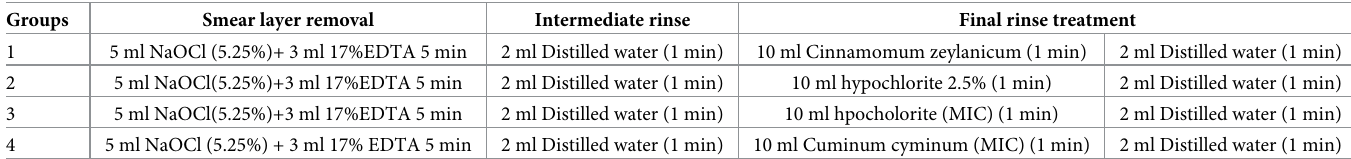
Table 1. Experimental groups and protocol of irrigation. Groups Smear layer